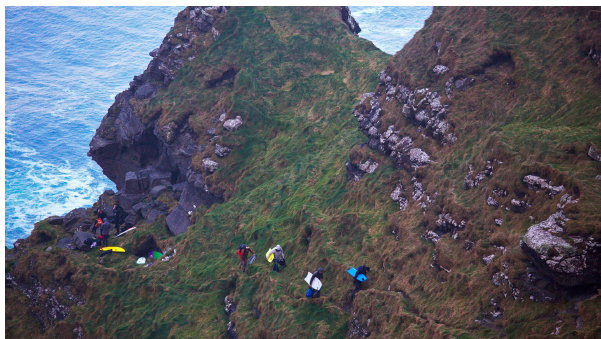
Figure 19. Tide gauge recordings from Galway Port during Storm Ophelia on 16 October 2017 (figure retrieved from The Marine In- stitute (2017b)).